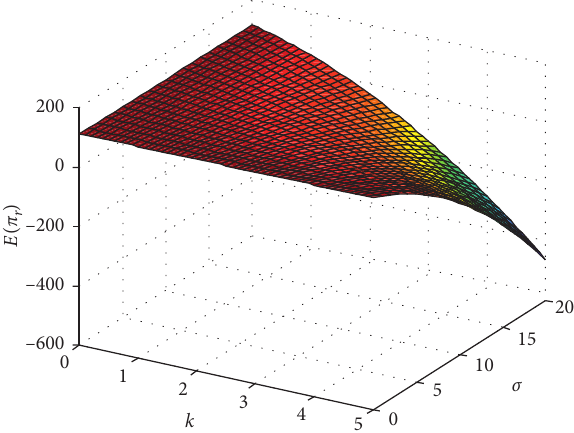
Figure 4: The trend of the retailer’s profits under the manufac- turer-dominant structure.